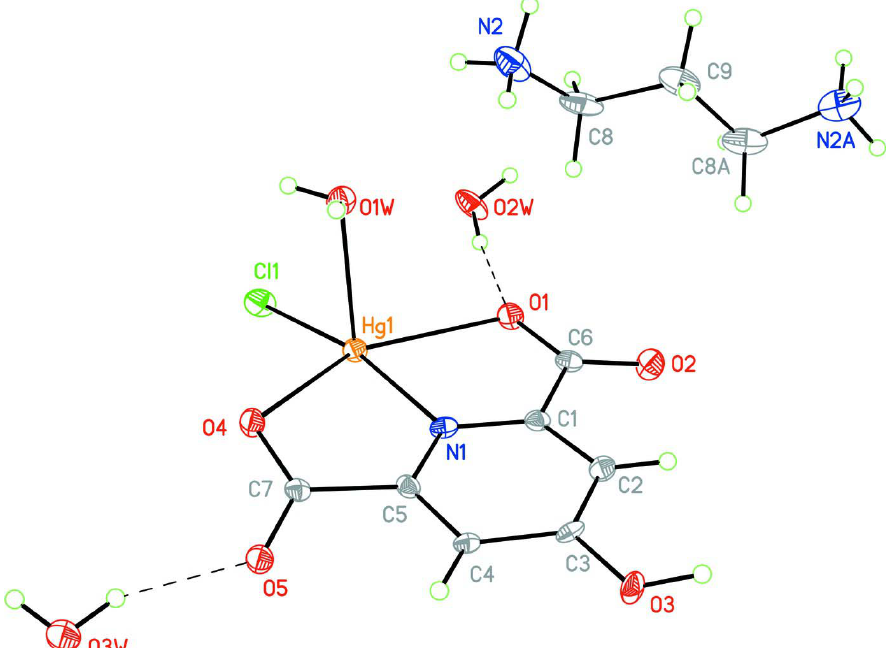
The molecular structure of the title compound, displacement ellipsoids are drawn at the 50% probability level. Hydrogen bonds are shown as dashed lines. Symmetry code A: - x + 1, y , - z +